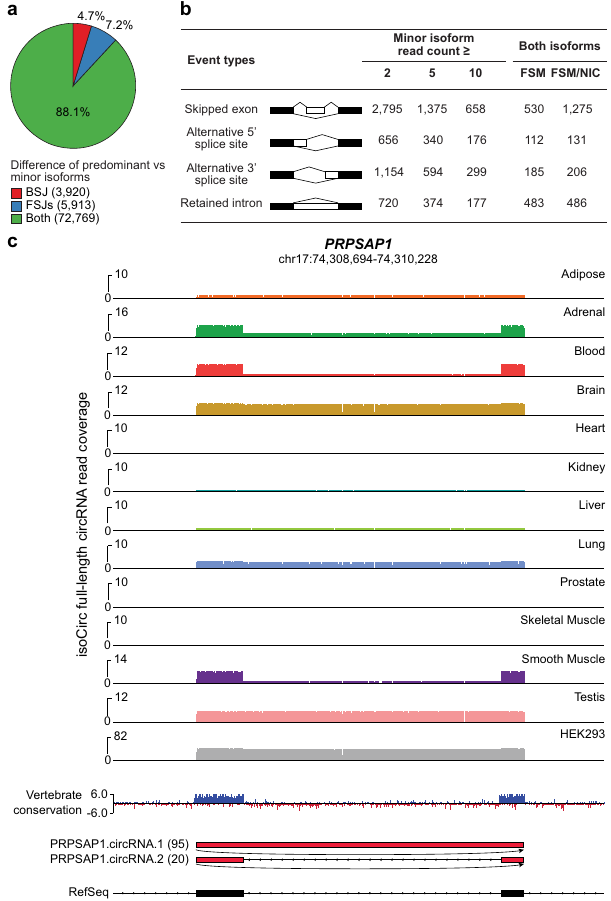
Fig. 4 isoCirc discovery of alternative splicing events within circRNAs. a Pie chart showing percentages of isoform pairs in which the predominant isoform (with highest median read count across 12 human tissues and HEK293 cell line for a given gene) had alternative splicing differences in BSJ only, FSJs only, or both compared to each of the other isoforms in the gene. Number of isoform pairs for each category is given in parentheses next to category name in the legend. b Summary table showing number of internal alternative splicing events within circRNAs corresponding to four major types of alternative splicing patterns, when requiring that the minor isoform had at least 2, 5, or 10 isoCirc reads. Number of internal alternative splicing events in which the splicing events of both isoforms had FSJs annotated as FSM only or FSM/NIC are represented in two rightmost columns. c isoCirc read coverage tracks for 12 human tissues and aggregated HEK293 replicates displaying the two most abundant circRNA isoforms of PRPSAP1 – PRPSAP1.circRNA.1 and PRPSAP1.circRNA.2, which had an alternative splicing event corresponding to a retained or spliced intron, respectively. A separate track displaying base-level conservation scores across vertebrates (phyloP 46-way) is supplied. Transcript structures and BSJs of PRPSAP1. circRNA.1 and PRPSAP1.circRNA.2 are shown using red boxes and black arrows. Total number of reads across all 12 human tissues and HEK293 replicates for each isoform is indicated next to the isoform identi fi